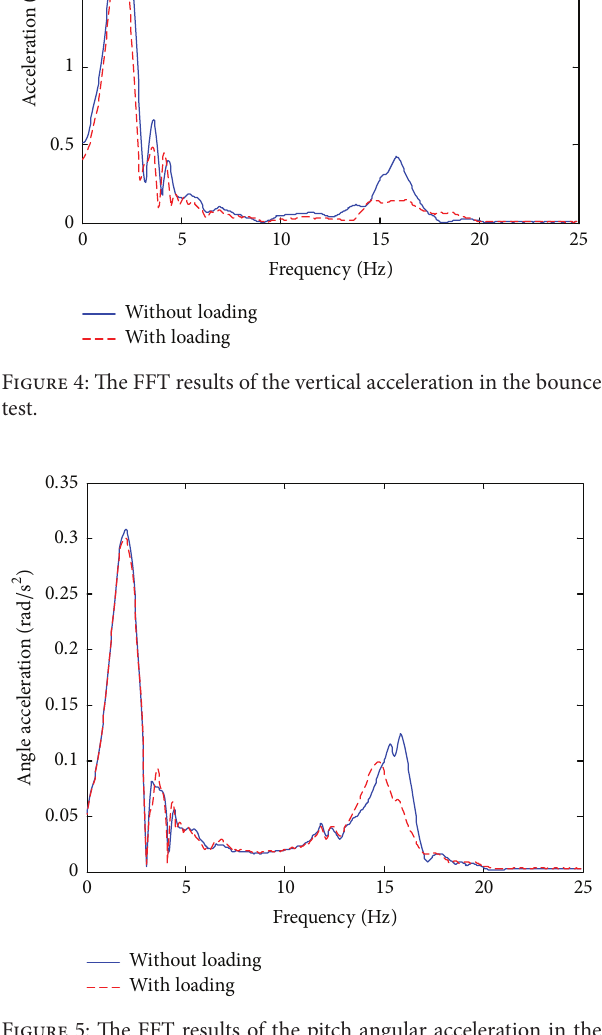
Figure 3: Accelerometer location of the chassis.